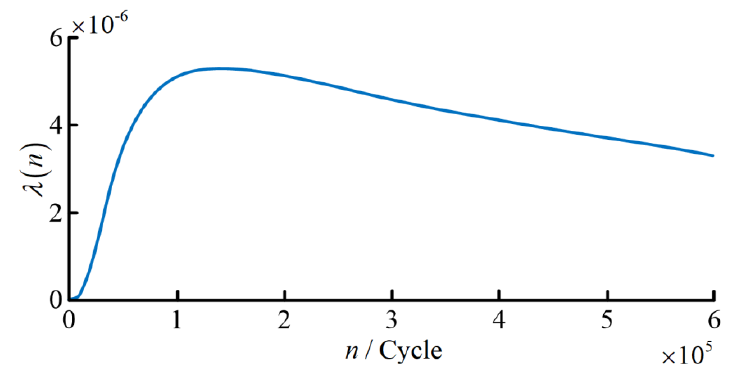
Figure 8. Failure rate curve of Ti-6246 alloy.